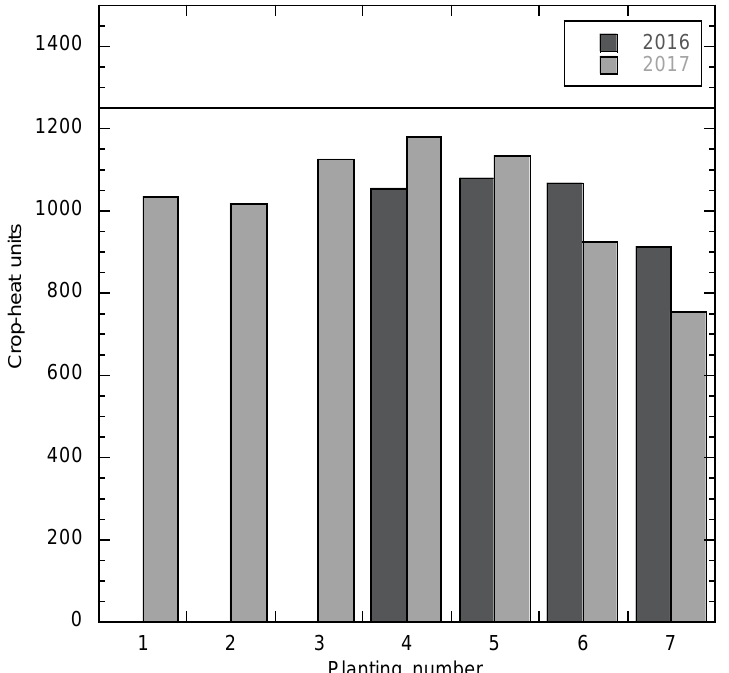
Figure 12. Accumulated crop-heat units for four plantings in 2016 and seven plantings in 2017. Crop-heat units represent heat units (15.5 °C base) that accumulated between the planting date and the date that the planting reached maturity in each year. The horizontal line indicates 1250 heat units that are a putative benchmark for crop maturity.